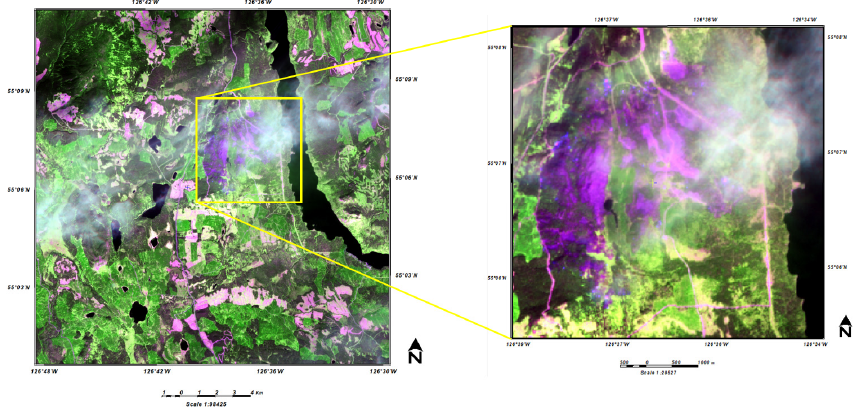
Figure 10. The cropped burning area for an enlarged visual comparison in Figure 11.